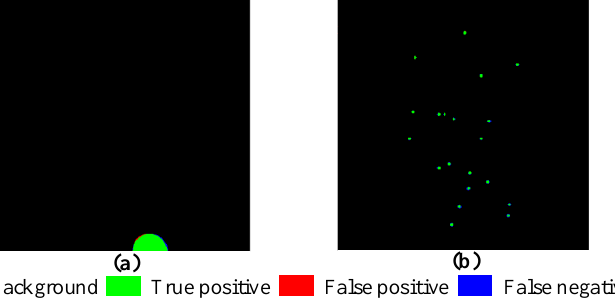
Figure 8. The foreground cluster region layer and sparse spots layer extracted by the proposed HTD method are compared with the labeled ground truth. ( a , b ) are the foreground cluster region and sparse spots, respectively, extracted by